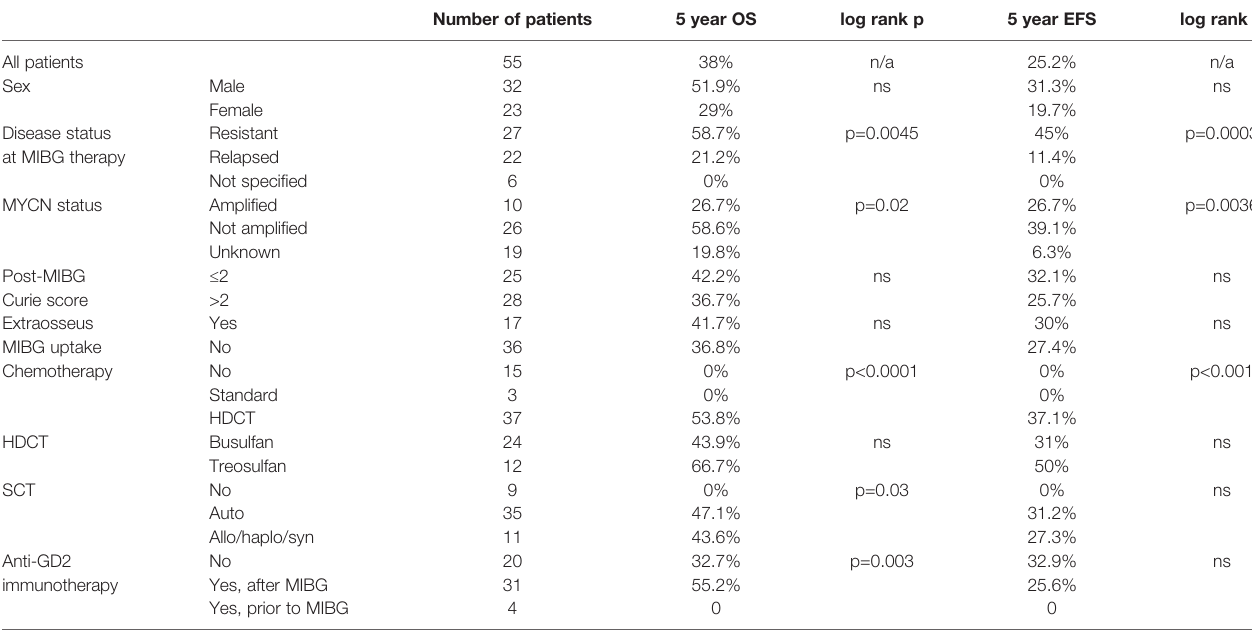
TABLE 2 | Survival after MIBG therapy.